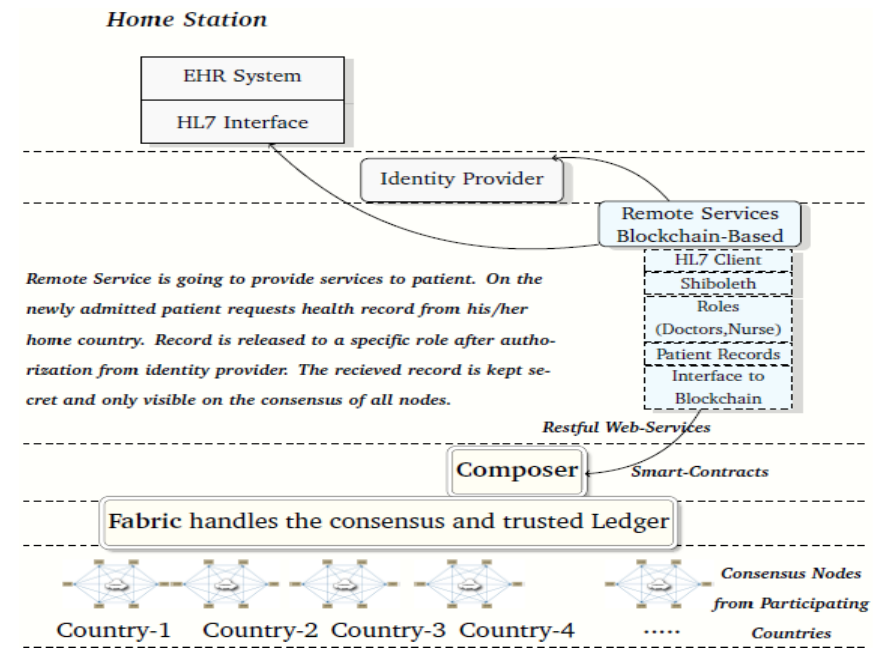
Figure 5. Proposed architecture.